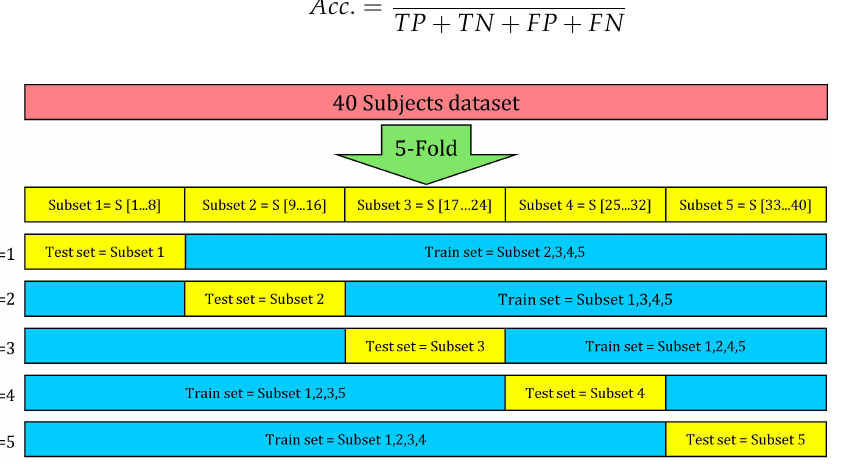
Figure 12. The structure of the 5-fold cross-validation procedure for train and test set splits of the 40 subject dataset.